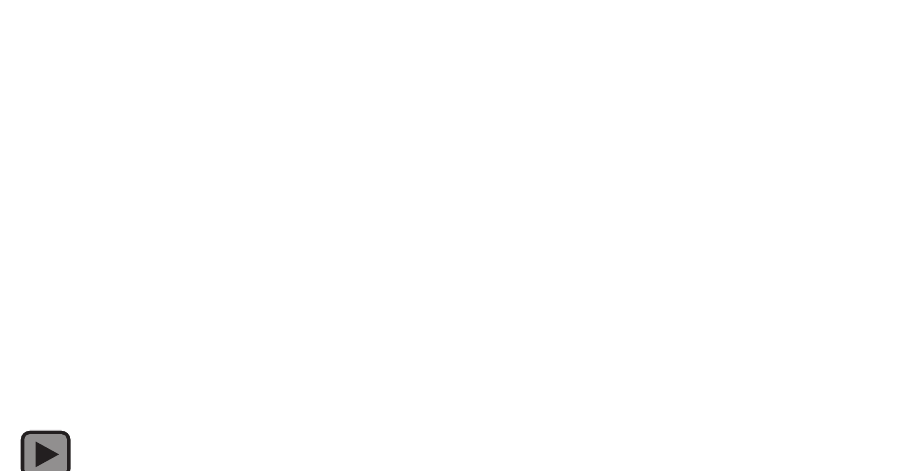
Figure 9. Video of the 3D model of Tethyopsis brondstedi (Burton, 1929) (MNA 2839), a very uncom- mon sponge only occurring in the Ross Sea. The diameter of the main spherical body is ~10 mm and the length/width of the oscular tubes are respectively ~30 mm and ~5